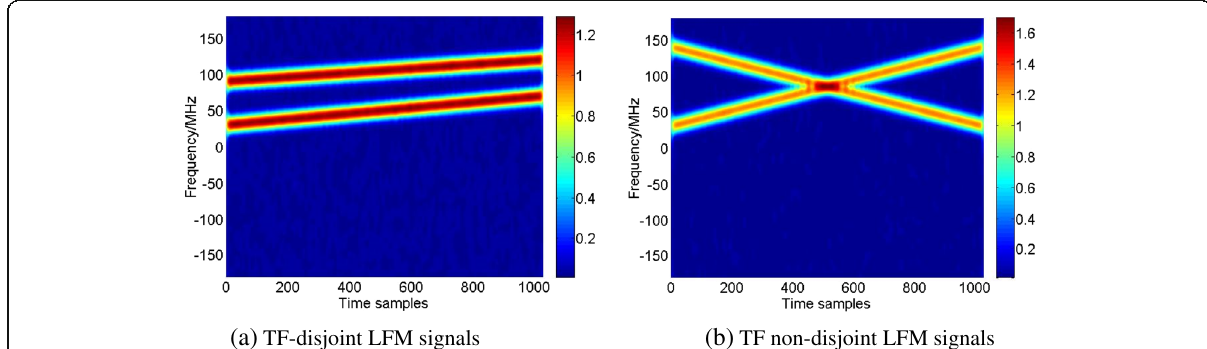
Fig. 1 TF distribution condition of LFM signals, ( a ) TF-disjoint LFM signals, ( b ) TF non-disjoint LFM